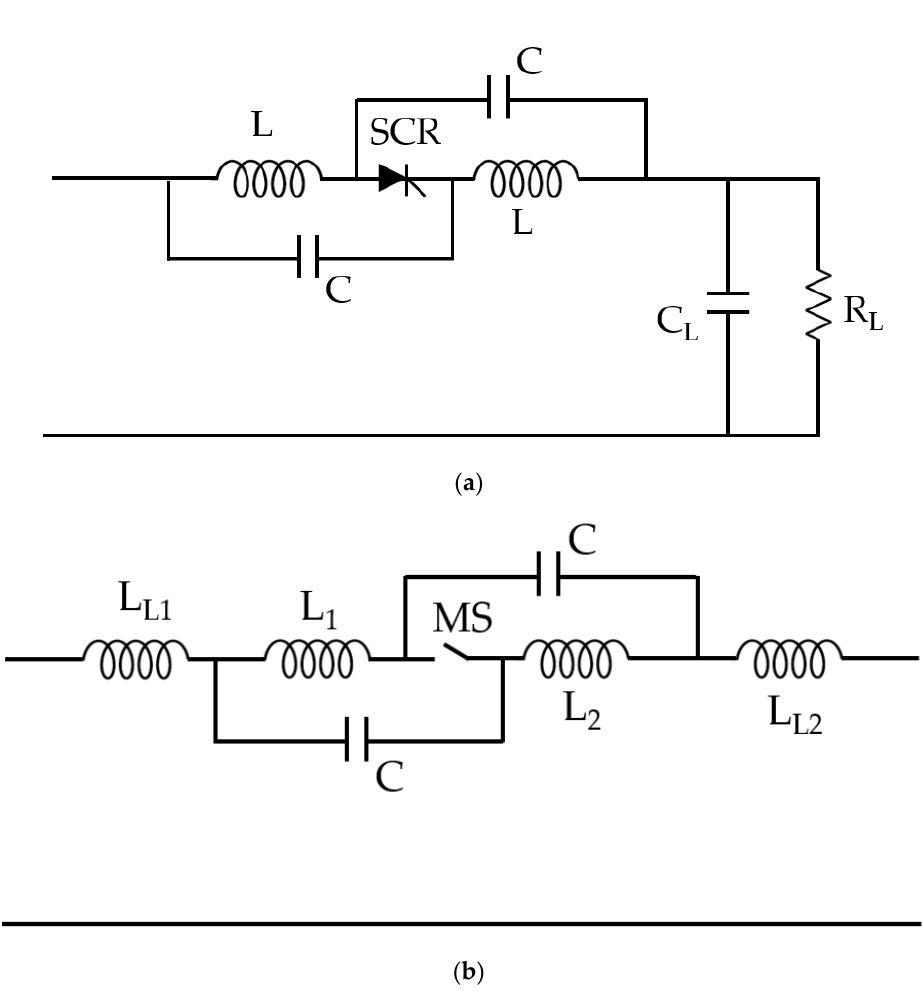
Figure 2. Z-source circuit breaker: ( a ) parallel ZCB, proposed in [22]; ( b ) ZCB with mechanical switch, proposed in [30].